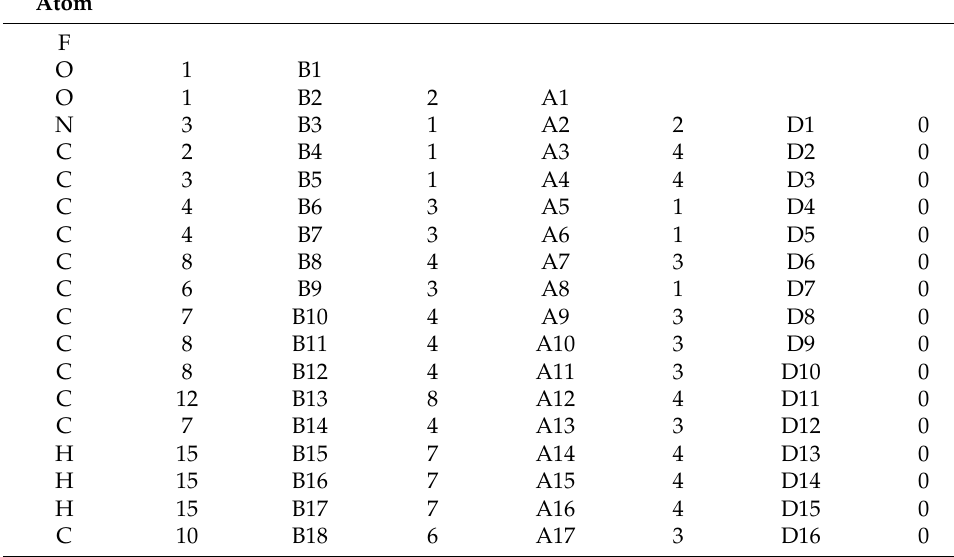
Table A3. Z − matrix of